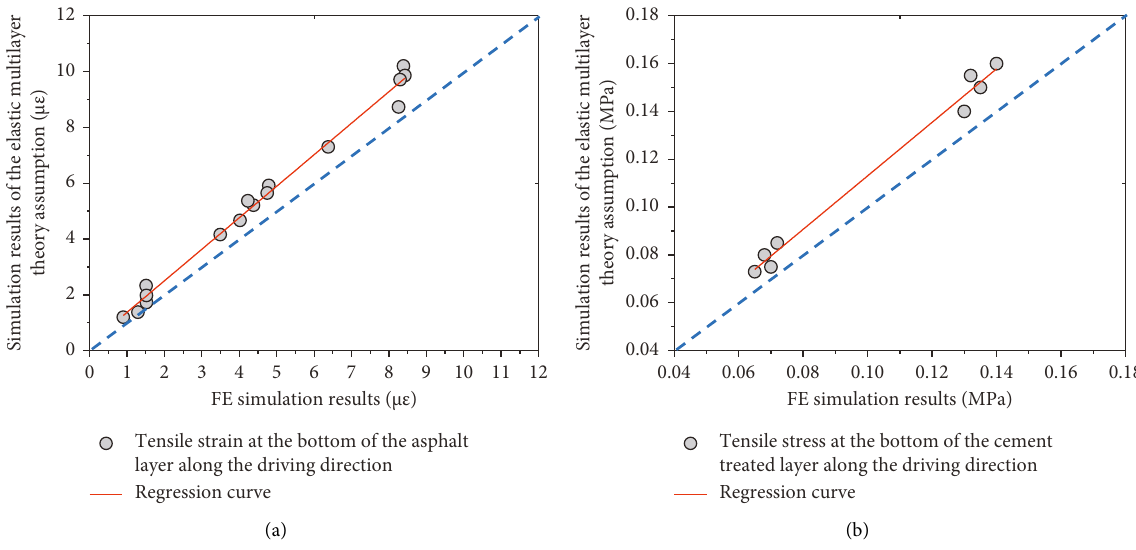
Figure 13: The calculation results of two methods. (a) The calculation results of the tensile strain at the bottom of the asphalt layer along the driving direction. (b) The calculation results of tensile stress at the bottom of the cement treated layer along the driving